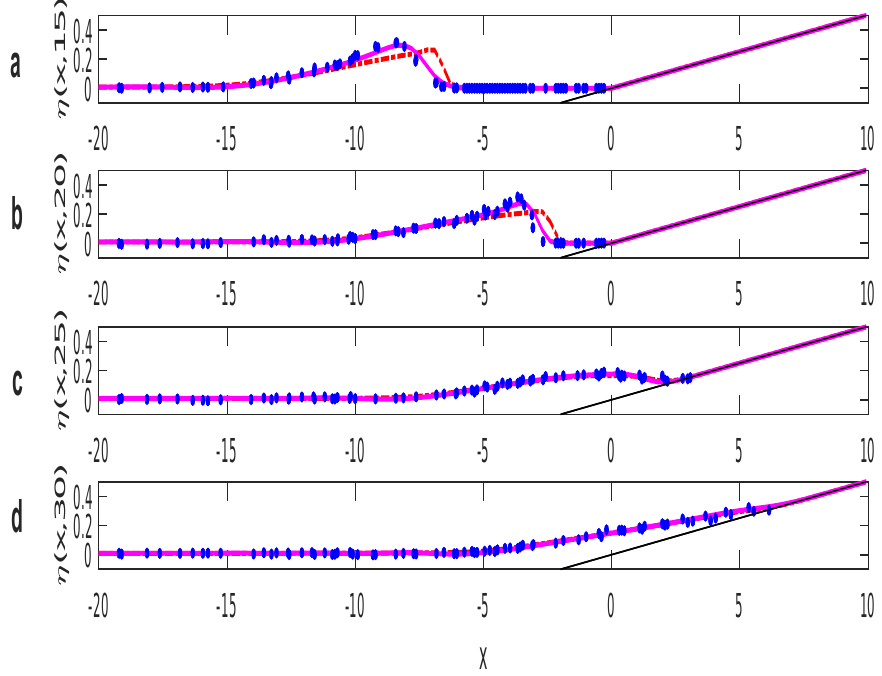
Figure 7. Wave surface profile for A / d 0 = 0.3 at ( a ) t = 15, ( b ) t = 20, ( c ) t = 25, ( d ) t = 30. Experiment data (.), hydrostatic model (- -), and non-hydrostatic model (-).